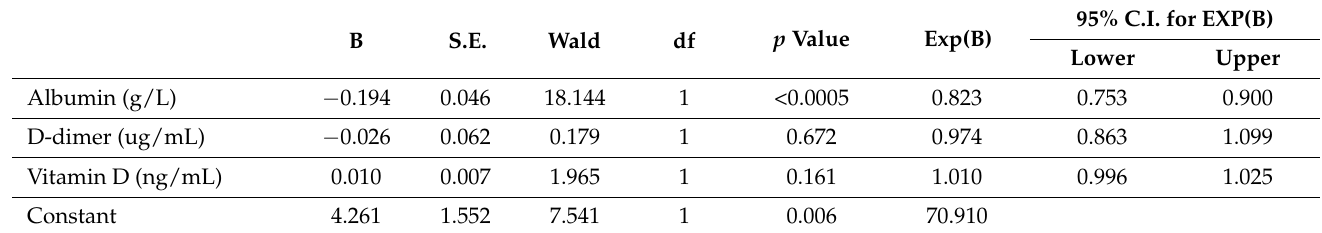
Table 5. Prediction of the probability of developing a fatal outcome in patients with COVID-19. The serum values of the biochemical parameters were obtained from blood samples immediately after admission to the hospital for treatment (n = 288). Statistical significance was examined using the binary logistic regression. Values of p < 0.05 were considered statistically